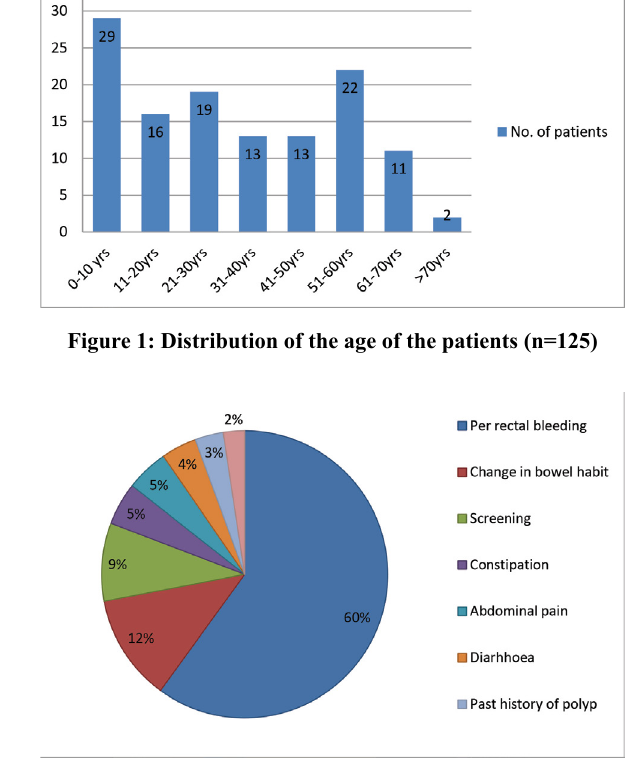
Figure 2: Indication for lower gastro endoscopy examination (n=125) Most of the biopsies were received from the rectum (49.7%) which was followed by the sigmoid colon (15.6%). (Figure 2)Out of 168 polyps, 118 polyps were pedunculated and 50 were sessile.